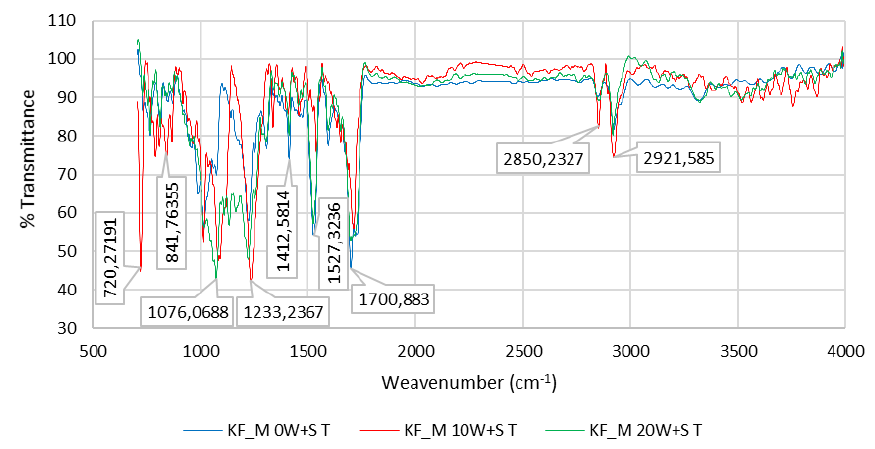
Figure 13. FTIR spectrum of the PU coating of sample KF_M (PU 58% / PES 42%) for 0 W + S, after 10 W + S and after 20 W + S.